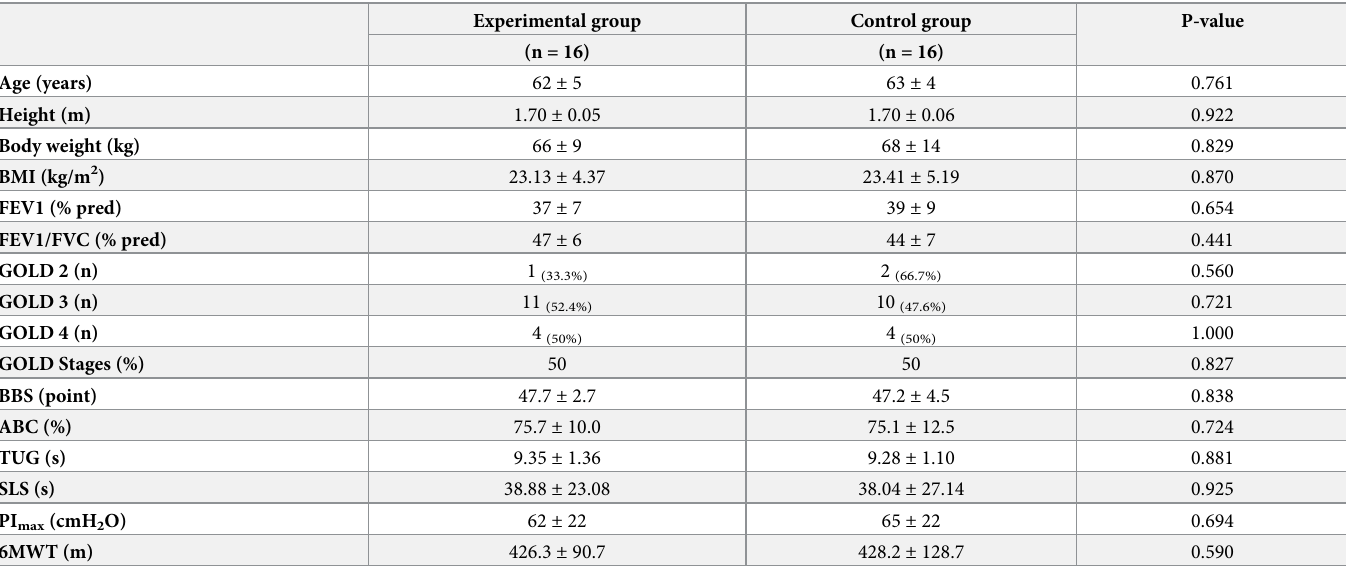
Table 2. Baseline patients’ characteristics and values of initial assessments.